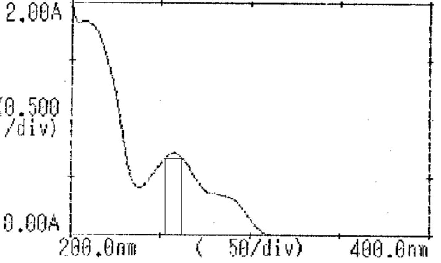
Figure 4. Area under curve of itopride hydrochloride in water